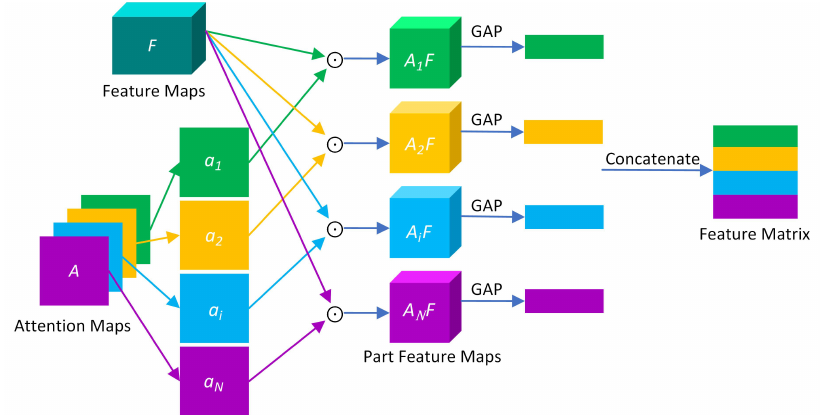
Figure 6. The process of